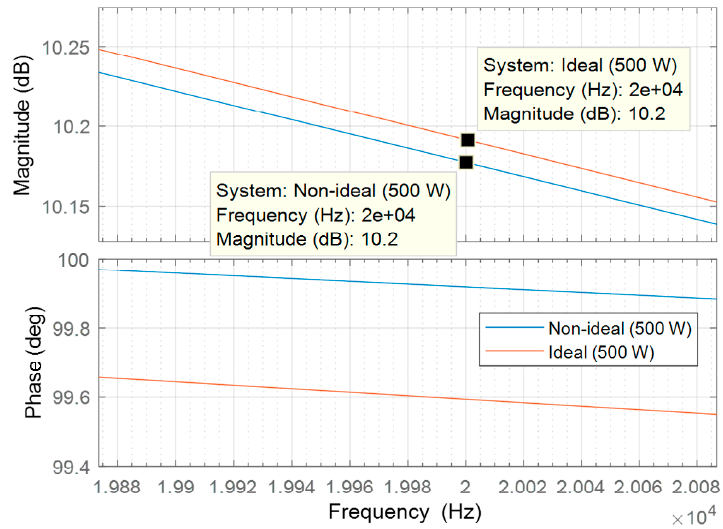
Figure 9. Bode plot showing effects of non-ideal characteristics on the system.